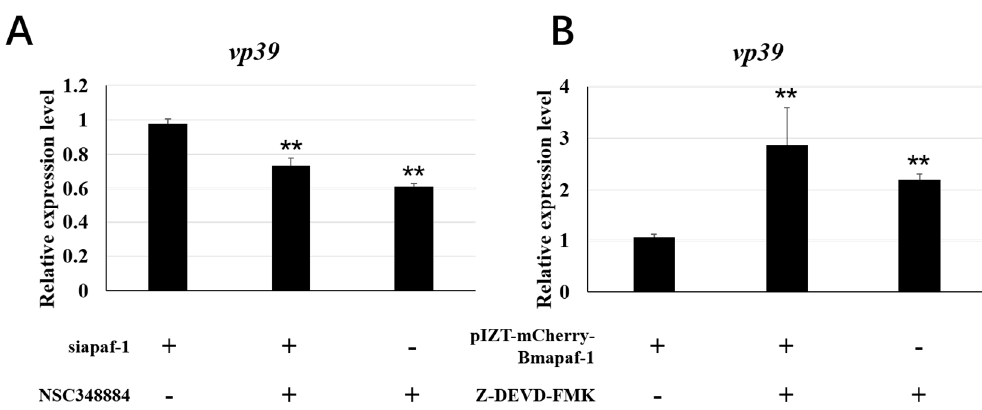
Figure 7. The analysis of BmNPV replication in the RNAi and overexpression group following regulation of apoptosis in BmN cells using RT-qPCR. ( A ) The replication of BmNPV in the RNAi group after treatment with inducer NSC348884. ( B ) The analysis of BmNPV replication in the transgenic BmN cell line following treatment with apoptosis inhibitor Z-DEVD-FMK. BmGAPDH was used to normalize the data that were shown as the mean ± standard error, the mean was from three independent repeats. The 2 − △△ Ct method was used to calculate the relative expression level. Differences among triple repeats were analyzed using the SPSS Statistics 20 software (IBM, USA) with the one-way ANOVA method. Asterisks represented the significant difference, as follows: ** p < 0.01.